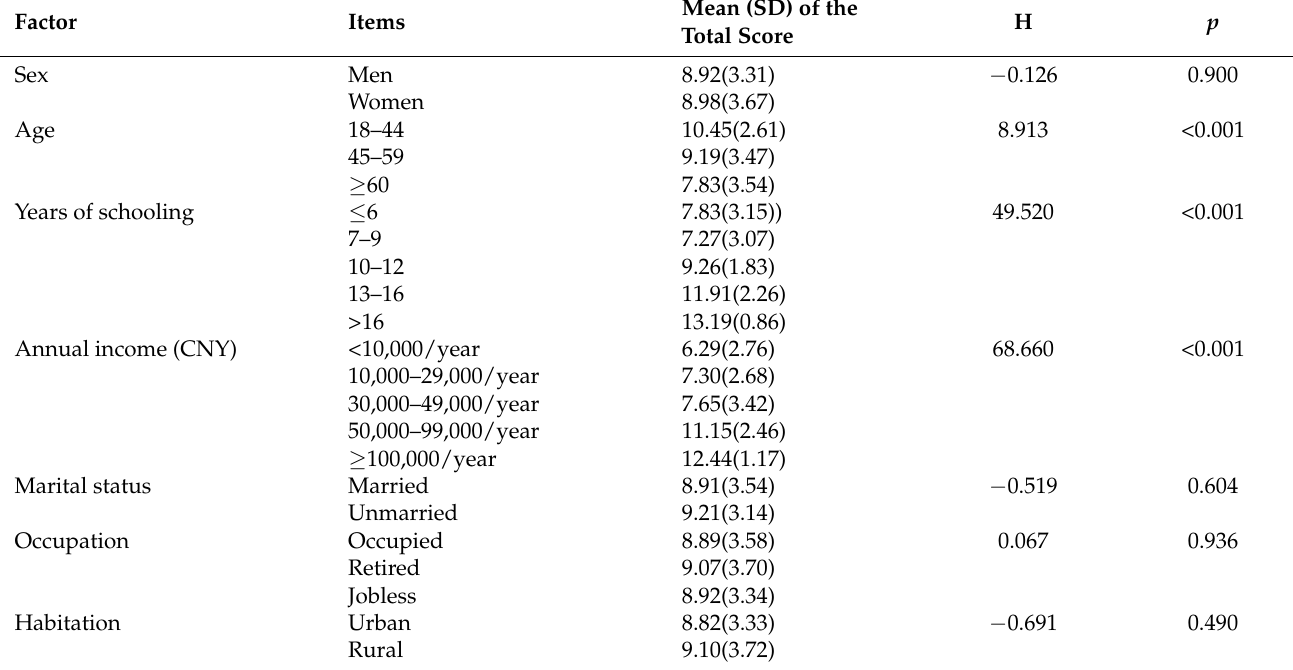
Table 3. Comparison of medication literacy scores in different groups of patients with stroke (N =